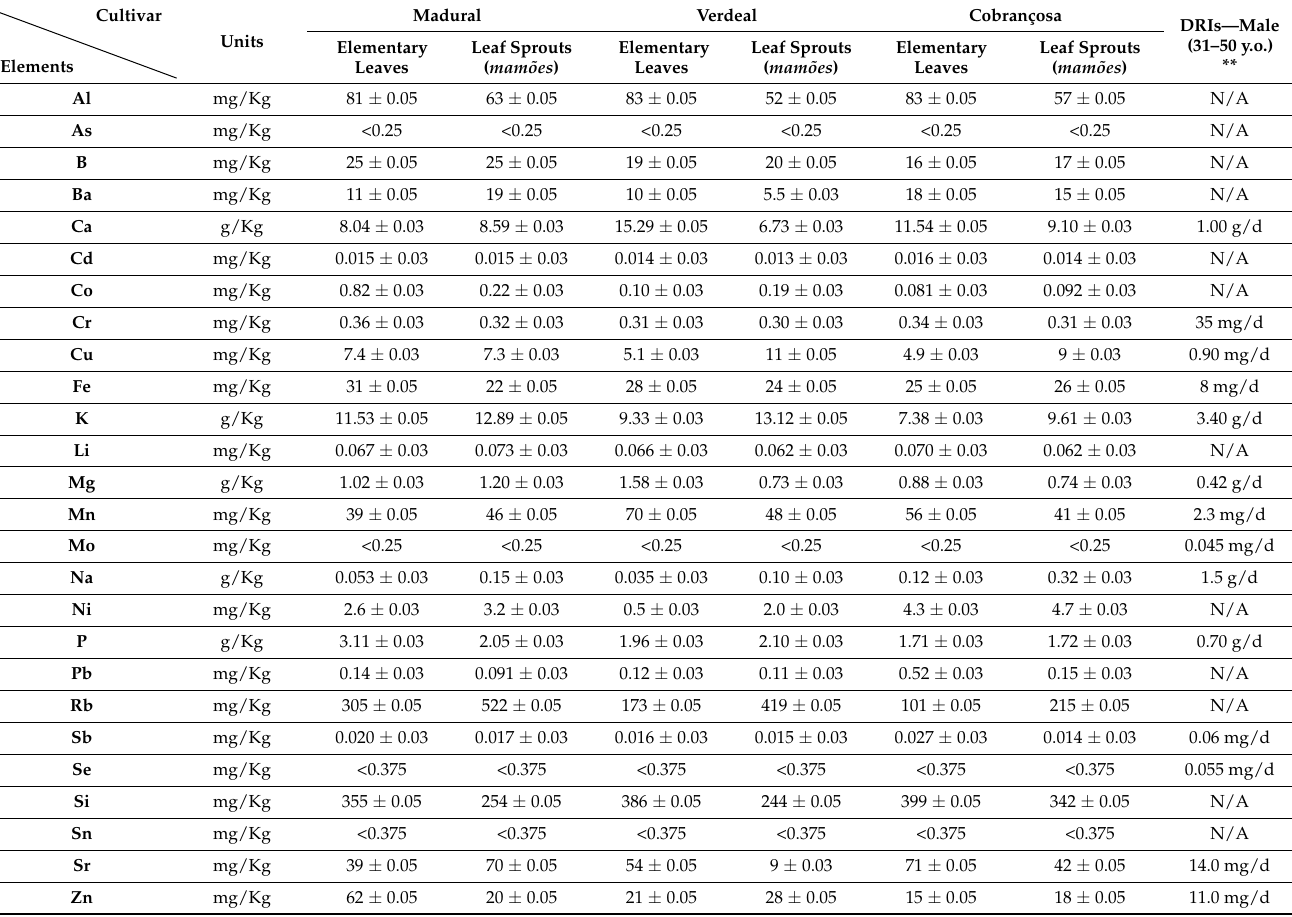
Table 1. Mineral analysis of leaf samples of O. europaea —study made with samples of leaves and leaf sprouts of three varieties at the Valpaços region from the North of Portugal—Madural, Verdeal, and Cobrançosa cultivars of olive tree. ** DRIs (daily recommended intake)—https: //nap.nationalacademies.org/read/11537/chapter/59#536 (Accessed on 14 November